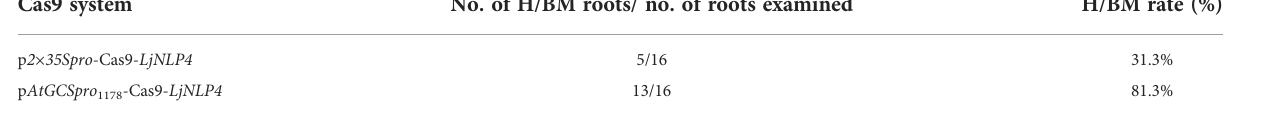
TABLE 2 Comparison of p AtGCSpro 1178 -Cas9 -LjNLP4 and p 2×35Spro -Cas9 -LjNLP4 genome editing ef fi ciency in L . japonicus hairy roots. Cas9 system